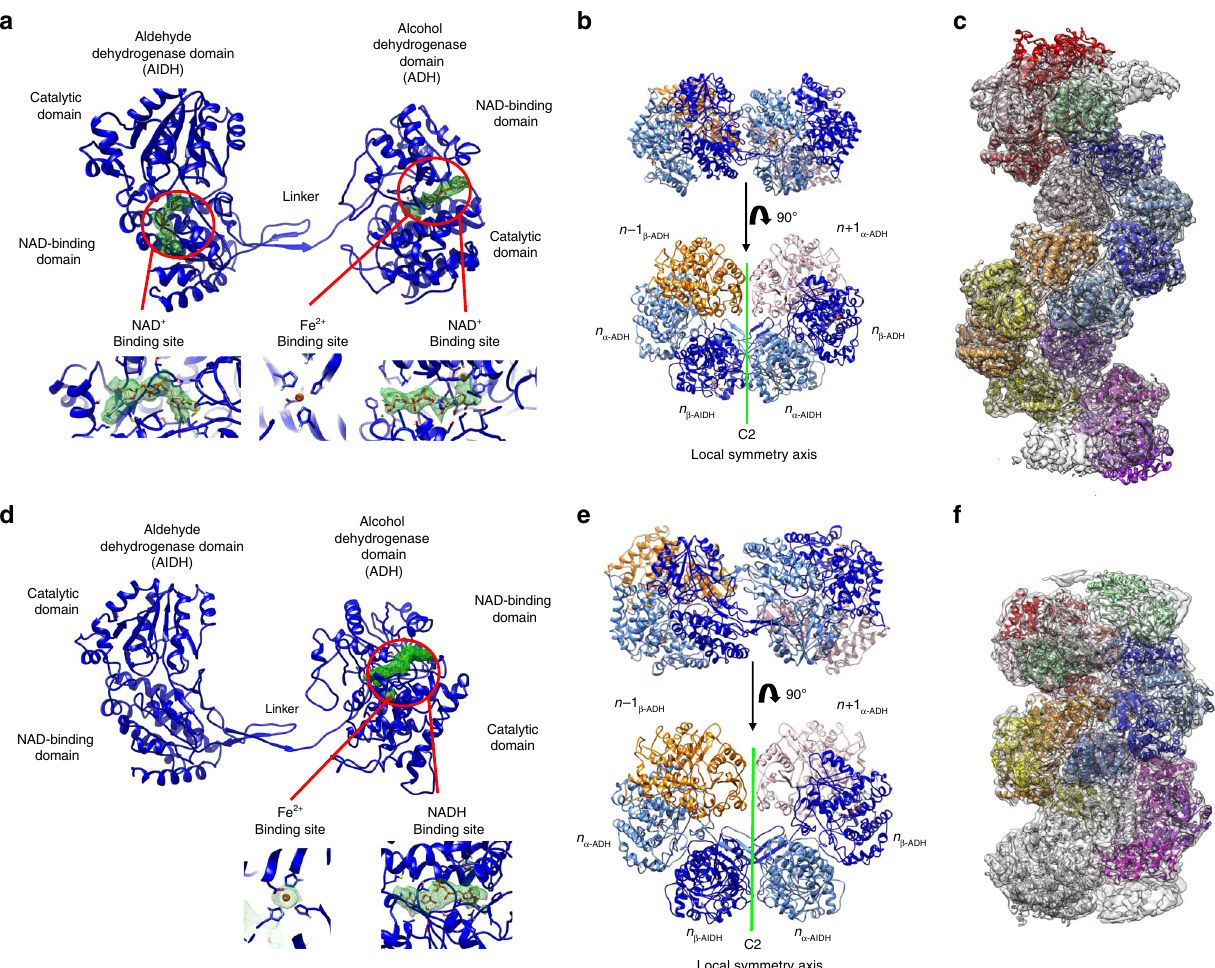
Fig. 2 Structure of AdhE in extended and compact fi laments. a Structure of the AdhE monomer in the presence of NAD + and Fe 2 + . The AlDH and ADH domains are identi fi ed. In each domain, the electron density corresponding to the NAD + and Fe 2 + is displayed in green mesh, as it is visible in the cryoEM map. In the lower part of the panel, larger views of the cofactor-binding sites are provided. b Structure of the AdhE dimer in its extended conformation. The AdhE n dimer is made of the α (in light blue) and β (in blue) protomers. Each protomer is composed of ADH and AlDH domains. The AdhE n dimer is in interaction with the ADH n − 1 and ADH n + 1 . The AdhE α and AdhE β are related by C2 symmetry. c Structural model of the AdhE fi lament in its extended conformation. This model was obtained by docking the structure of the AdhE dimer shown in b , in the cryoEM map obtained by HR and by duplicating this dimer along the fi lament axis using its helical symmetry. d Structure of the AdhE monomer in the presence of NADH and Fe 2 + . The AlDH and ADH domains are identi fi ed. In the ADH domain, the electron density corresponding to the NADH and Fe 2 + is displayed in green mesh, as it is visible in the cryoEM map. No density corresponding to the NADH is visible in the AlDH domain active site. In the lower part of the panel, larger views of the ADH cofactor-binding site are provided. e Structure of the AdhE dimer in its compact conformation. The AdhE n dimer is made of the α (in light blue) and β (in blue) protomers. Each protomer is composed of ADH and AlDH domains. The AdhE n dimer is in interaction with the ADH n − 1 and ADH n + 1 . The AdhE α and AdhE β are related by C2 symmetry. f Structural model of the AdhE fi lament in its compact conformation. This model was obtained by docking the structure of AdhE dimer shown in d , in the cryoEM map obtained by HR and by duplicating this dimer along the fi lament axis using its helical